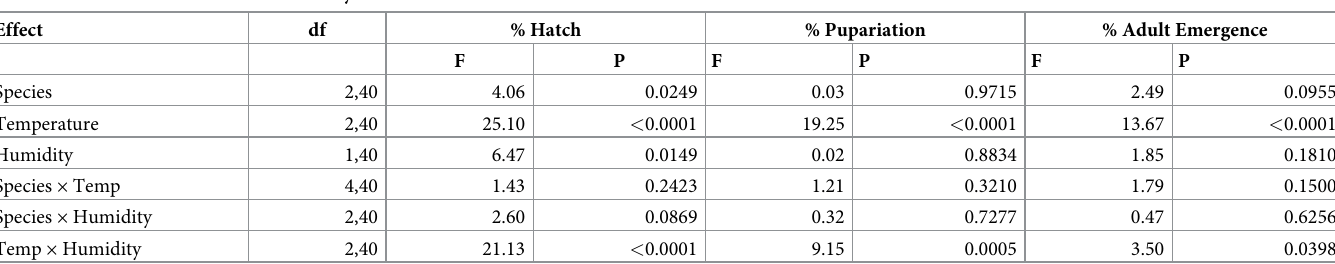
Table 1. Results of full model GLMM